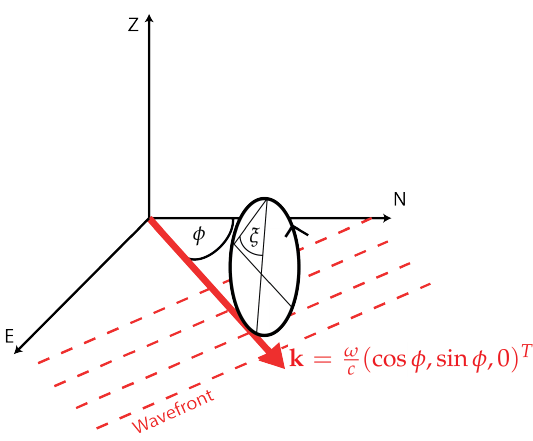
Figure 3. Schematic drawing of the plane harmonic model used to describe Rayleigh waves for single-station 6DOF